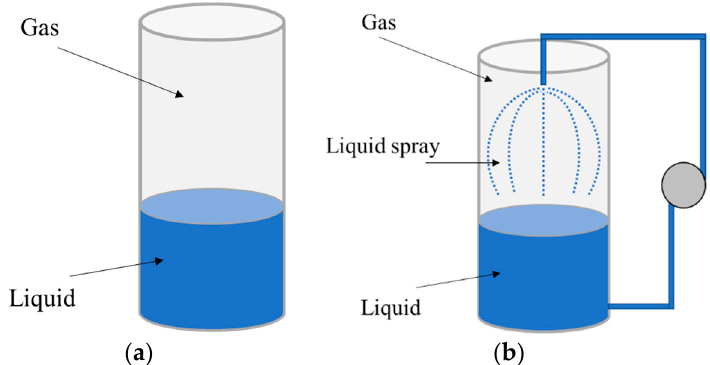
Figure 2. Scheme of the configurations studied: ( a ) First Configuration; ( b ) Second Configuration.